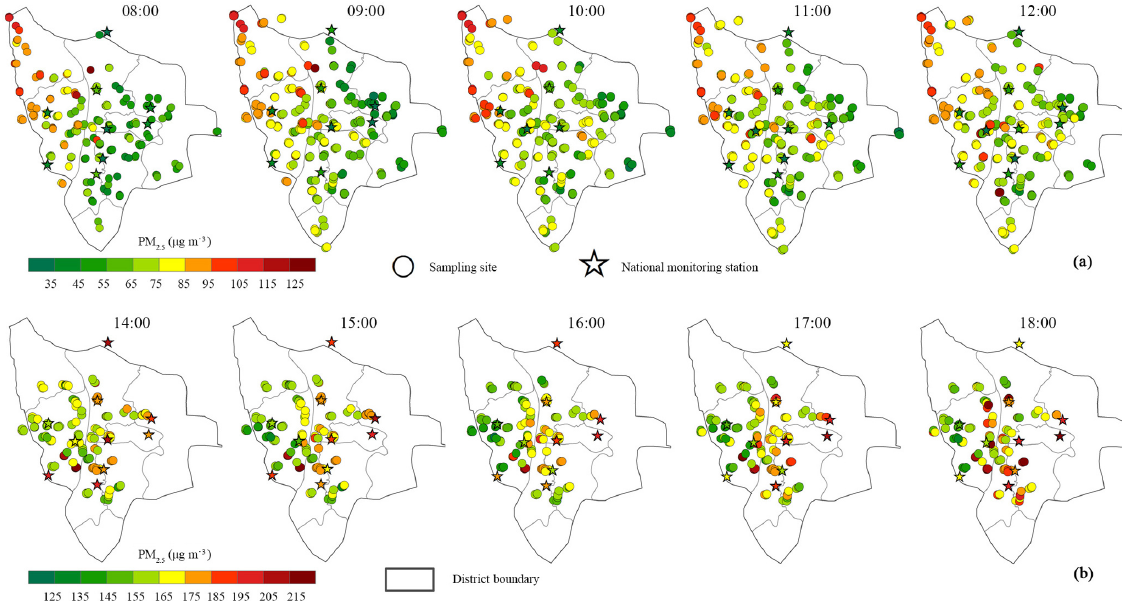
Figure 3. Spatial variation in PM 2 . 5 concentration of sampling sites: (a) Period 1, (b) Period